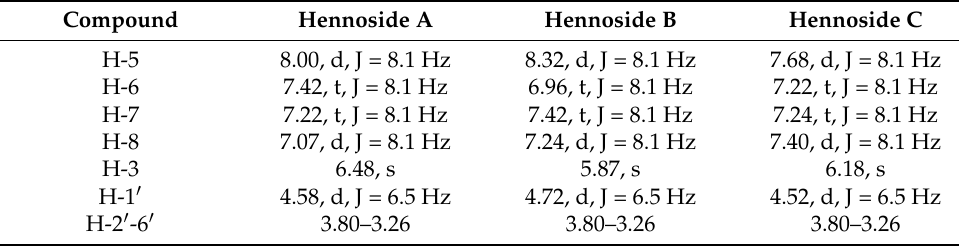
Table 3. Hennosides: 1 H NMR recorded data a